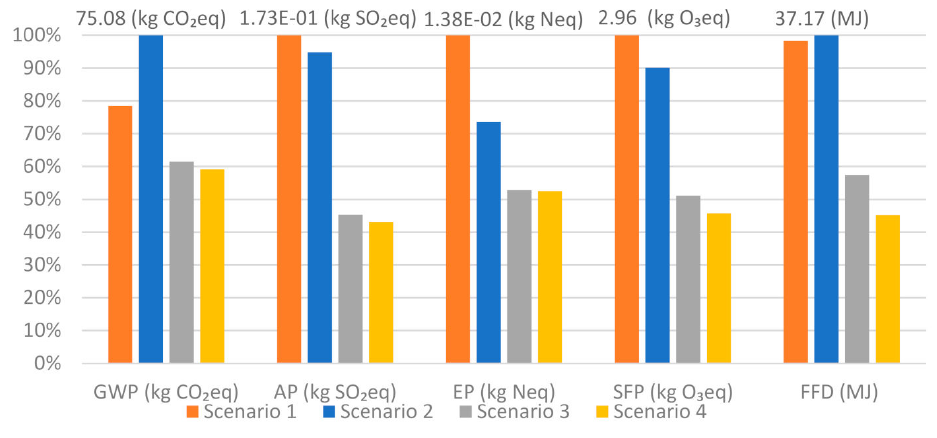
Figure 11. Overall life cycle assessment (LCA) results of the four studied